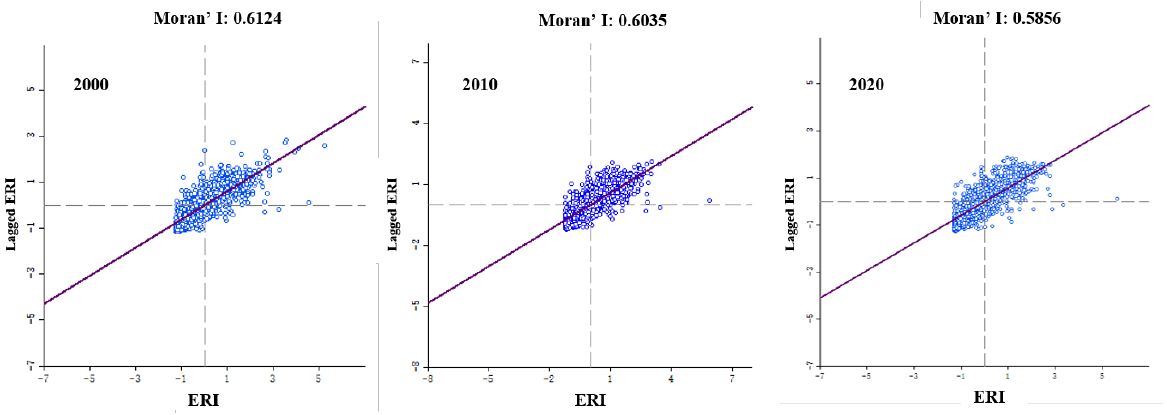
Figure 8. Distribution of the Moran-s I scatter of ecological risk from 2000 to 2020.